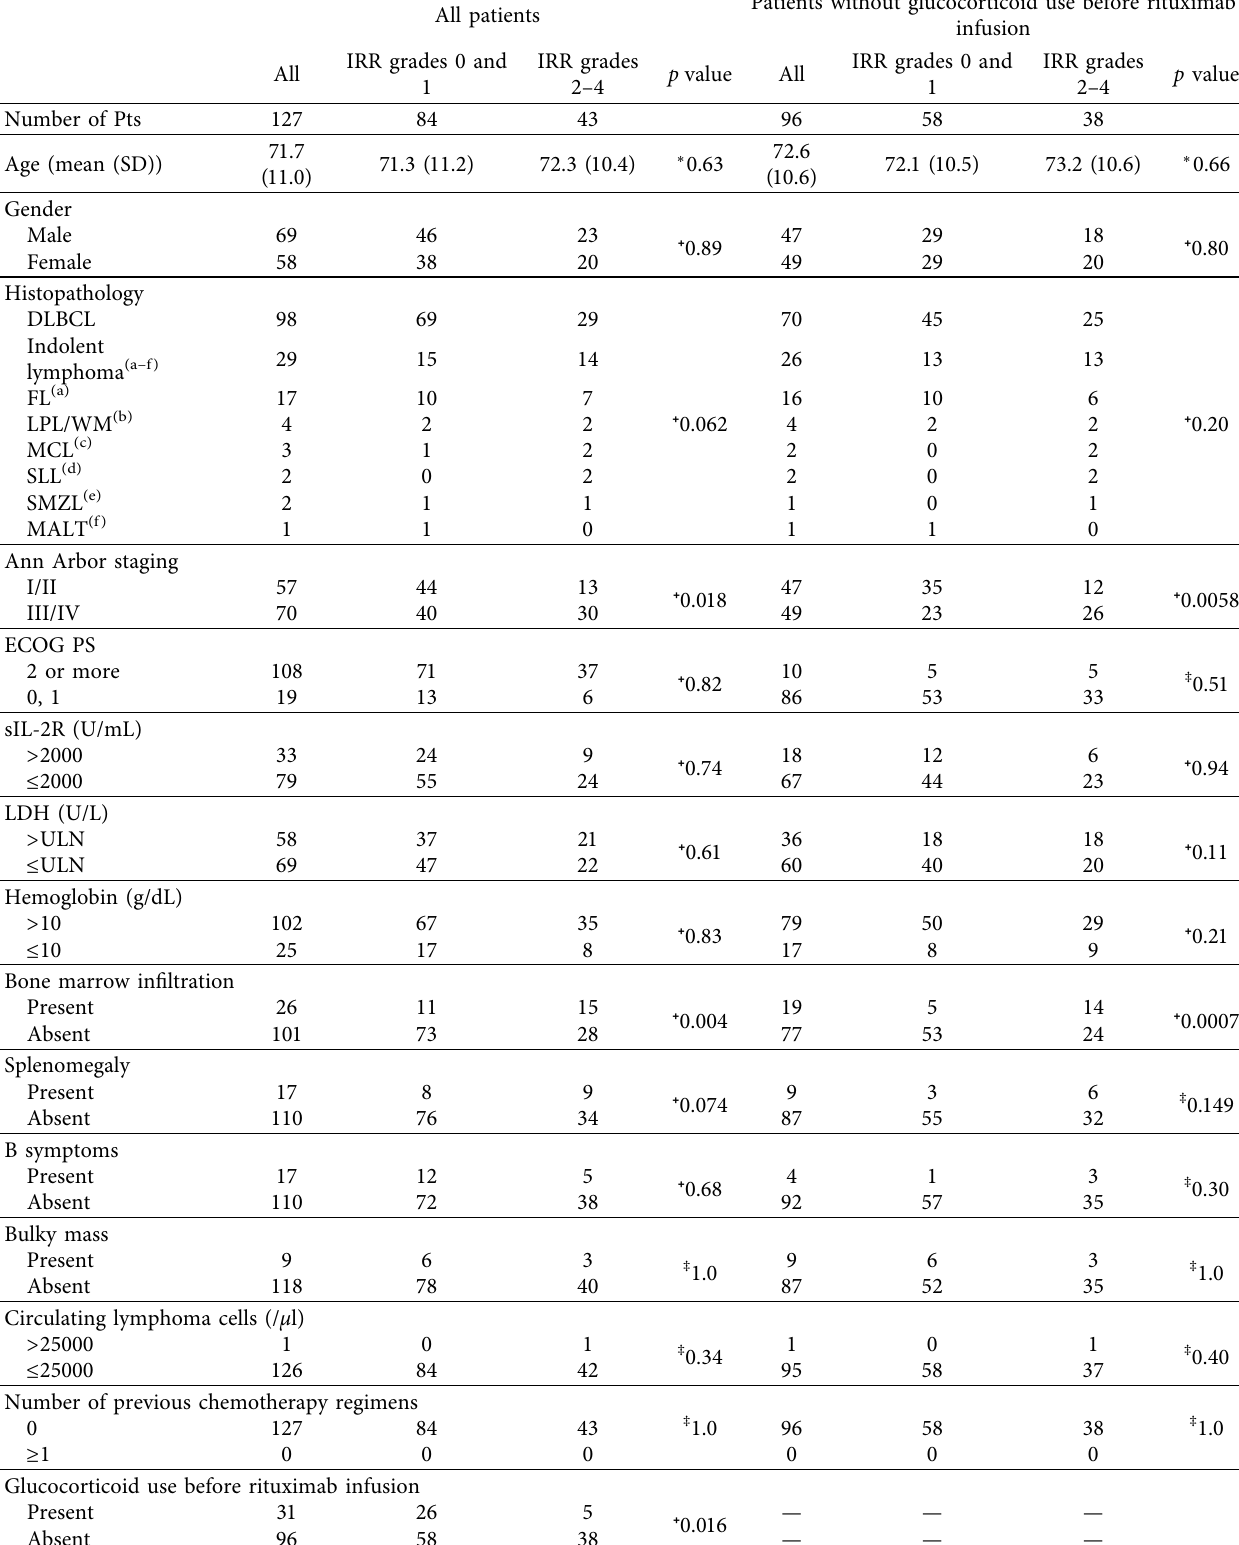
Table 1: Patient characteristics and clinical